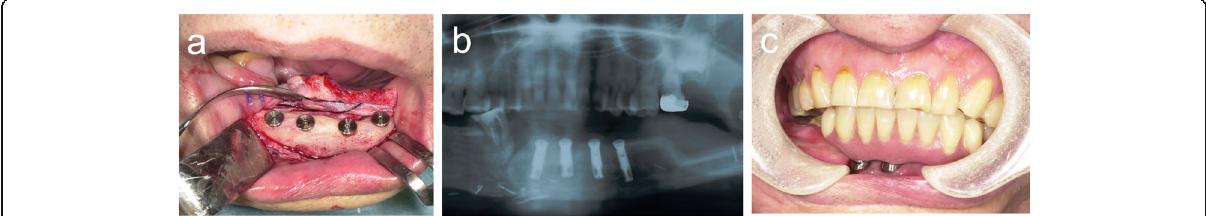
Fig. 7 a Four dental implants were inserted into the distracted fibula. b Orthopantomogram after implantation. c Intraoral view after treatment: the implant denture was placed on the mandible